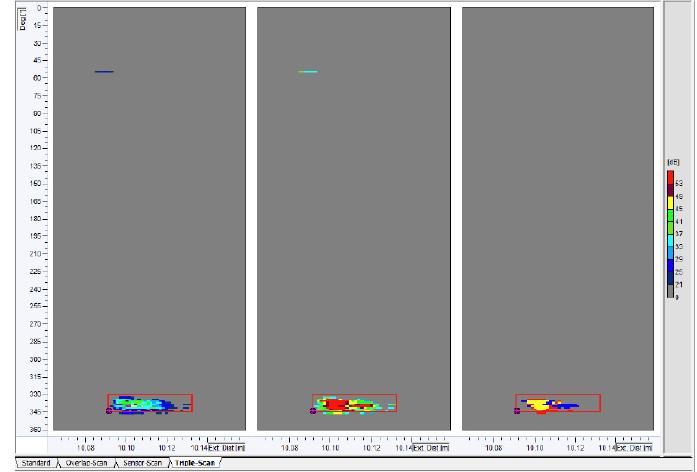
Figure 13. Signal of gouge in GW 17720 base metal.